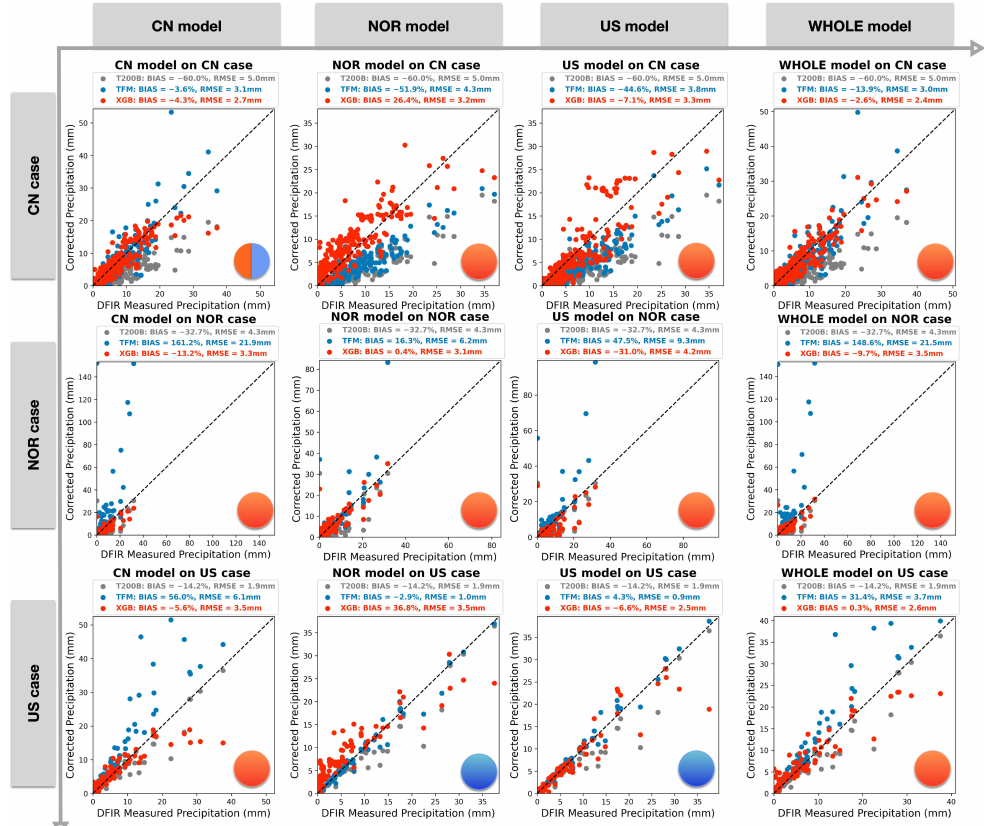
Figure 10. The transferring performance of the XGB precipitation correction method between different sites in Norway (NOR), the United States (US), and our study area in China (CN). The X-axis represents the trained model in CN, NOR, and US, while the Y-axis represents the site cases in CN, NOR, and US. Each subfigure displays the result of the trained model applied to a specific site. For example, ’CN model on US case’ indicates that the trained CN model using CN data was applied to correct the US case. The WHOLE model was trained using the training data from NOR, US, and CN. The XGB results (in red) are the uncorrected T200B or single-alter gauge observation (in grey) and the traditional TFM correction (in blue) are scattered. The BIAS and RMSE are listed in each subfigure. A solid cycle located in the lower-right of each subfigure indicates if the XGB model outperforms the TFM model, with orange meaning the XGB model outperforms the TFM model in RMSE and BIAS, and blue meaning the opposite. Half blue and half orange indicate that the XGB model outperforms the TFM model in one of the RMSE and BIAS